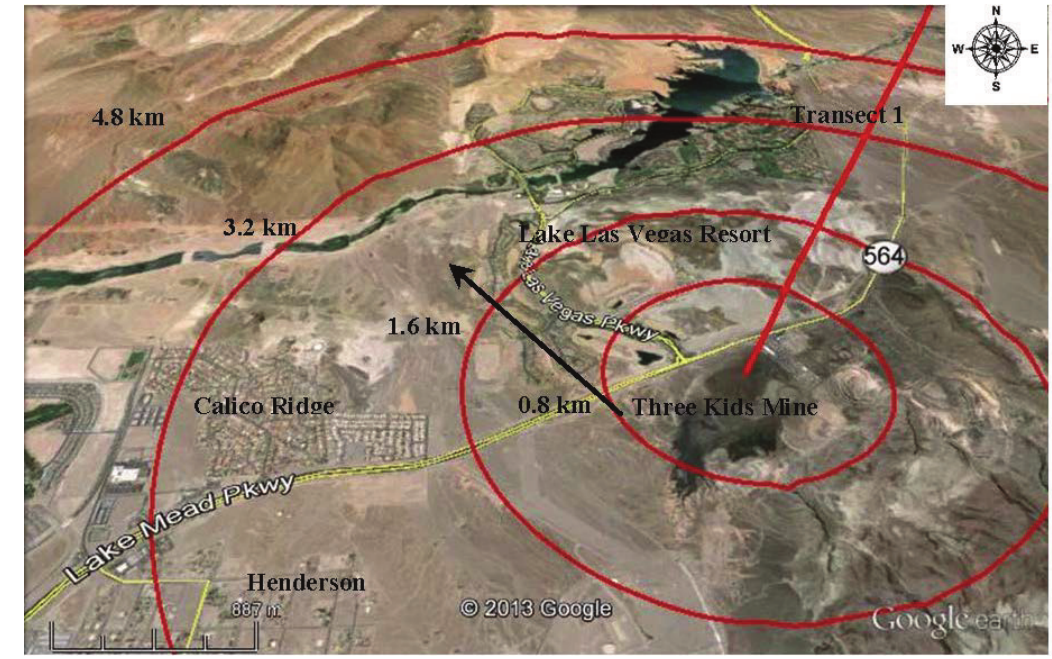
Figure 4. Photo showing encroachment of housing projects in the vicinity of the TKM. The light colored area to the east and just north of Lake Mead Parkway has new home sites. Google